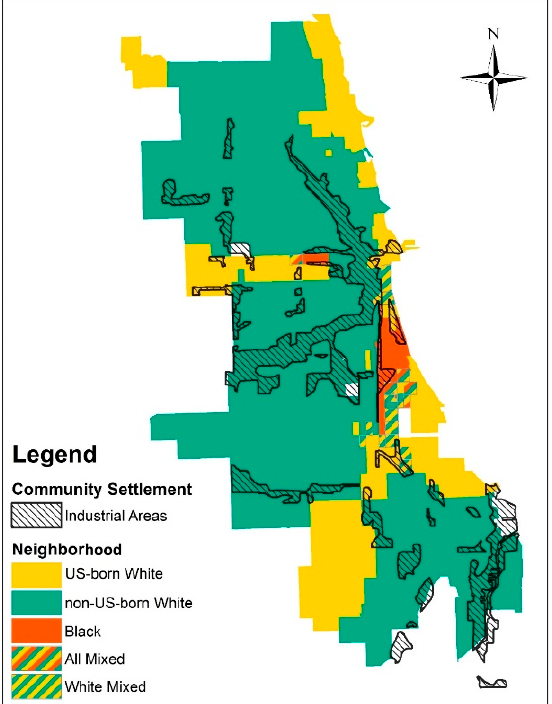
Figure 1. Majority race and identified industrial areas by community settlement in Chicago at the time of the 1918 influenza pandemic.